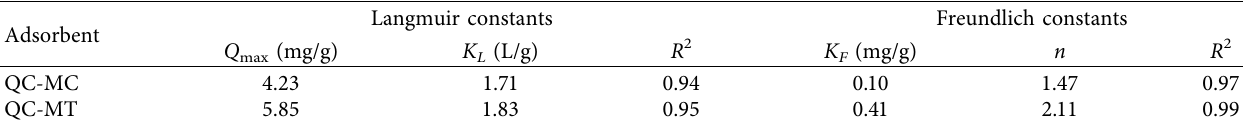
Figure 7: Adsorption isotherm for removal of Cd (II). (a) Isotherm curve and (b) Langmuir and (c) Freundlich models ( V � 100mL, T � 25 ° C, m � 1.5g, contact time � 30min for QC-MC and 45min for QC-MT, and pH � Table 2: Parameters of adsorption isotherm model.